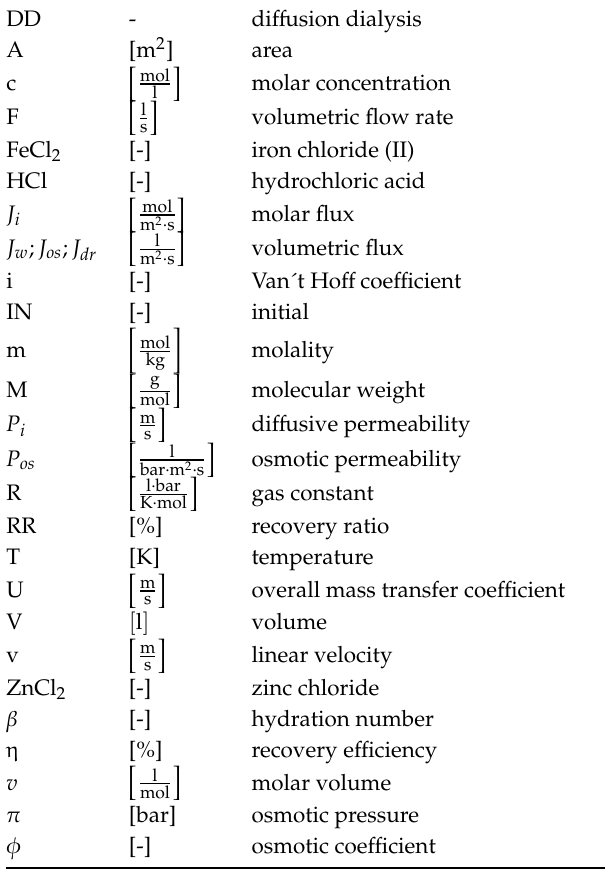
Table S1: Properties of Fumasep FAD type anion exchange membrane. Table S2: Dissociation reactions for the HCl + ZnCl2 and HCl + FeCl2 systems and relative equilibrium constants (source: PHREEQC Dissociation). Author Contributions: Data curation, R.G. and A.R.A.; Funding acquisition, A.C. and G.M.; Investigation,